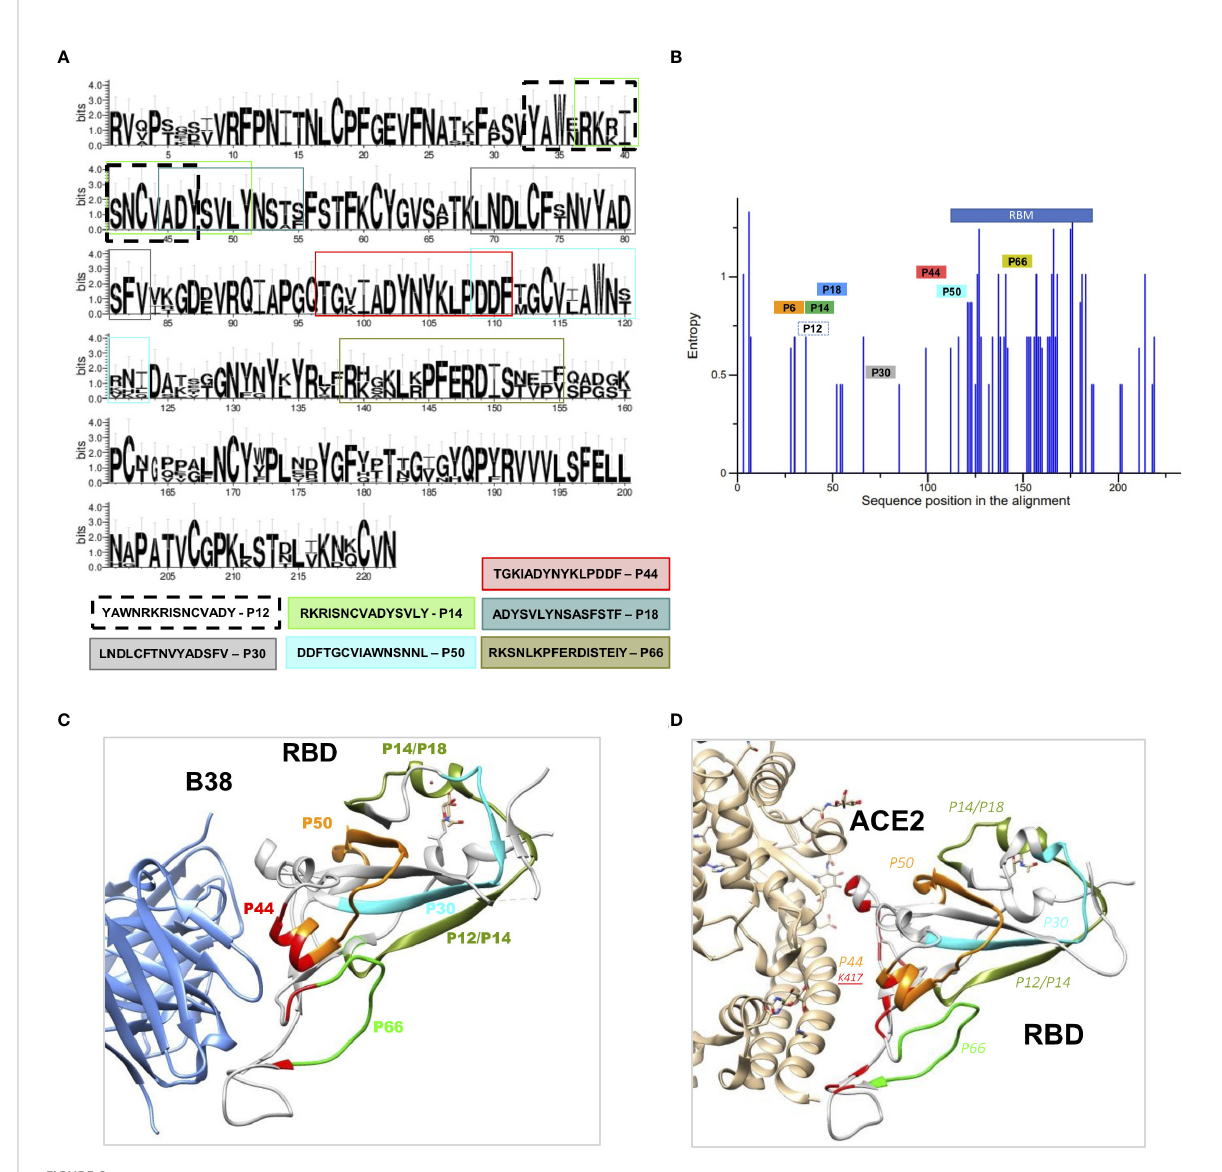
FIGURE 2 Structural and conservation evaluation of topmost recognized peptides (A) Conservation analysis of the top recognized peptides among RBD proteins from coronaviruses of the B lineage, SARS-CoV-2, SARS-CoV, SARS-SZ3, Rs3367-bat, CoV-pangolin, and RaTG13-bat. The height of the letters in the logo plot re fl ects the frequency of the amino acid in the multiple sequence alignment. (B) Entropy of aminoacid residues, top peptides highlighted, of the alignment made at (A, C) . RBD binding to the therapeutic neutralizing antibody B38 (pdb: 7BZ5) and with ACE-2 (D) interacting with P44, with contact amino acid residues in red. SARS-CoV-2 RBD (light gray). Colored regions show the most frequently recognized peptides identi fi ed among convalescents, namely, orange: P44: peptide 44 (S 415-429 ), silver P6: peptide 6 (S 353-367 ), golden P12, P14 and P18, peptide 12, 14, and 18 (S 365-379 , S 370-384 , S 378-392 ), blue P30: peptide 30 (S 397-401 ), violet P50, peptide 50 (S 427-441 ) and green P66, peptide 66 (S 459-473